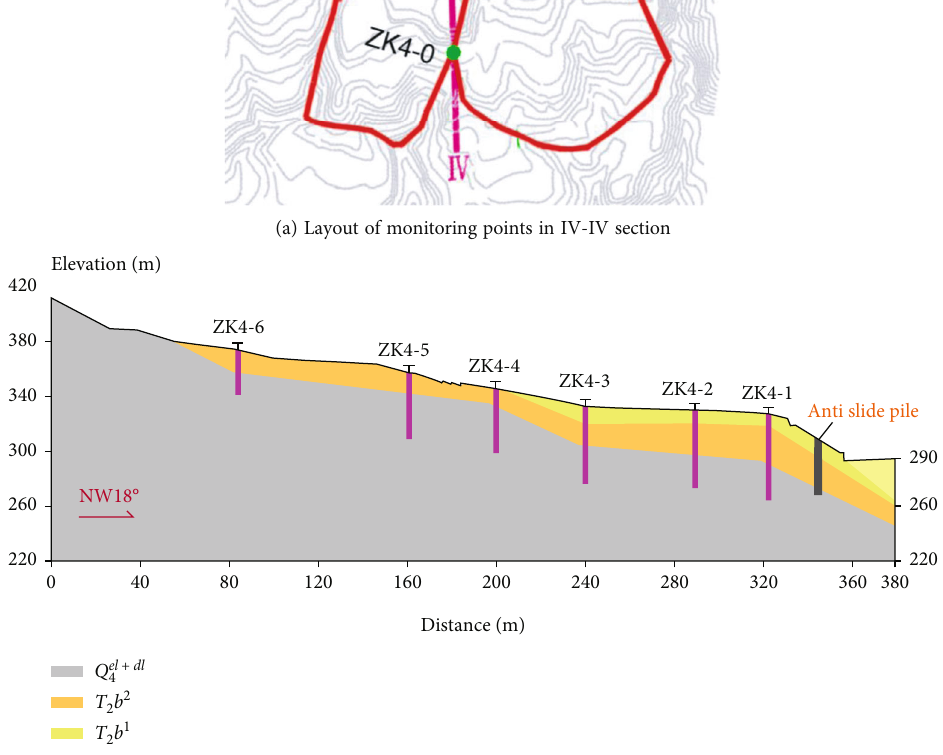
Figure 3: Layout of monitoring points and engineering geological pro fi le of section IV-IV (the black section of the IV-IV section in (a) corresponds to the geological structural map shown in